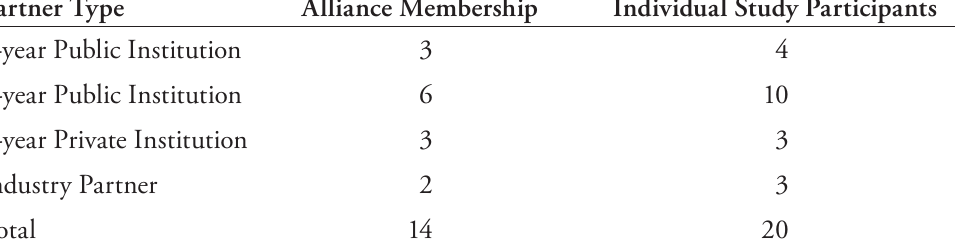
Table 1. Study Participant Institutional Type Partner